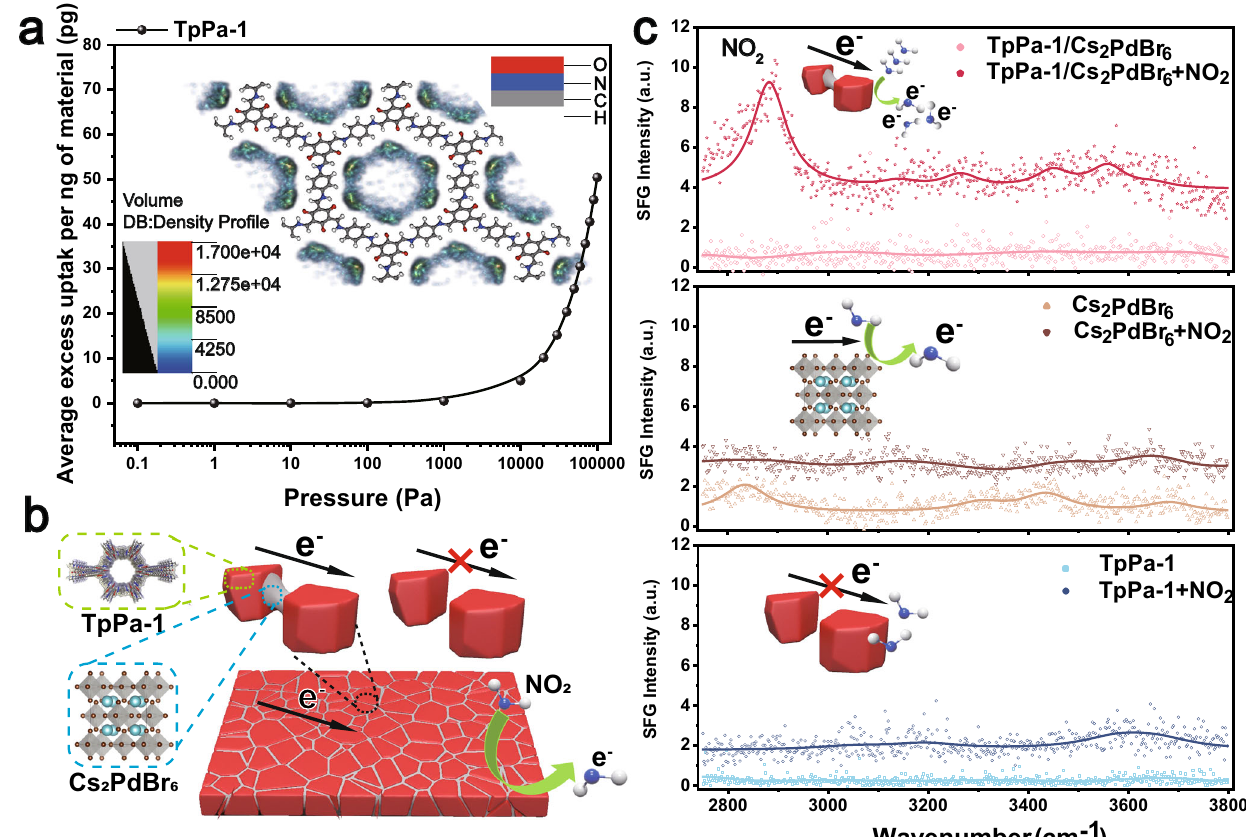
Fig. 5 | Characterization of the sensing mechanism. a Grand canonical Monte CarlosimulationofNO 2 adsorptiondensityplotonTpPa-1.Theinsetsin a showthe GCMC simulation of the average excess uptake of the NO 2 /N 2 mixture per ng of